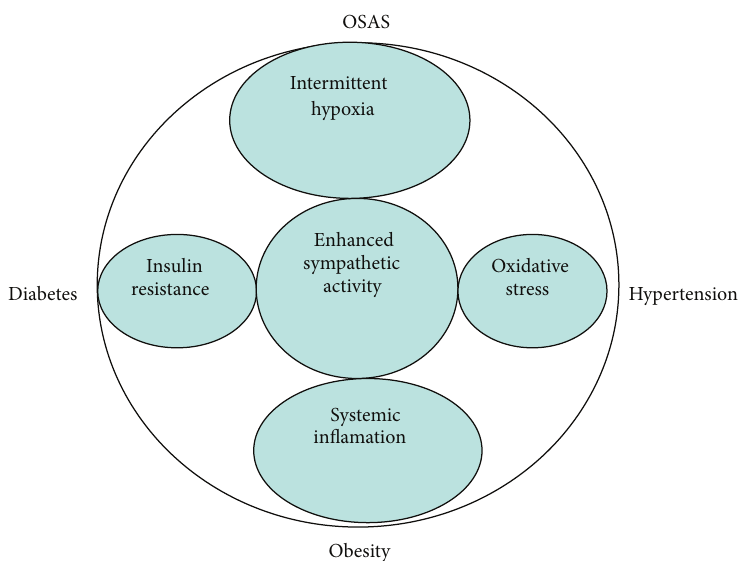
Figure 2: Obstructive sleep apnea syndrome and metabolic syndrome. Current perspective.